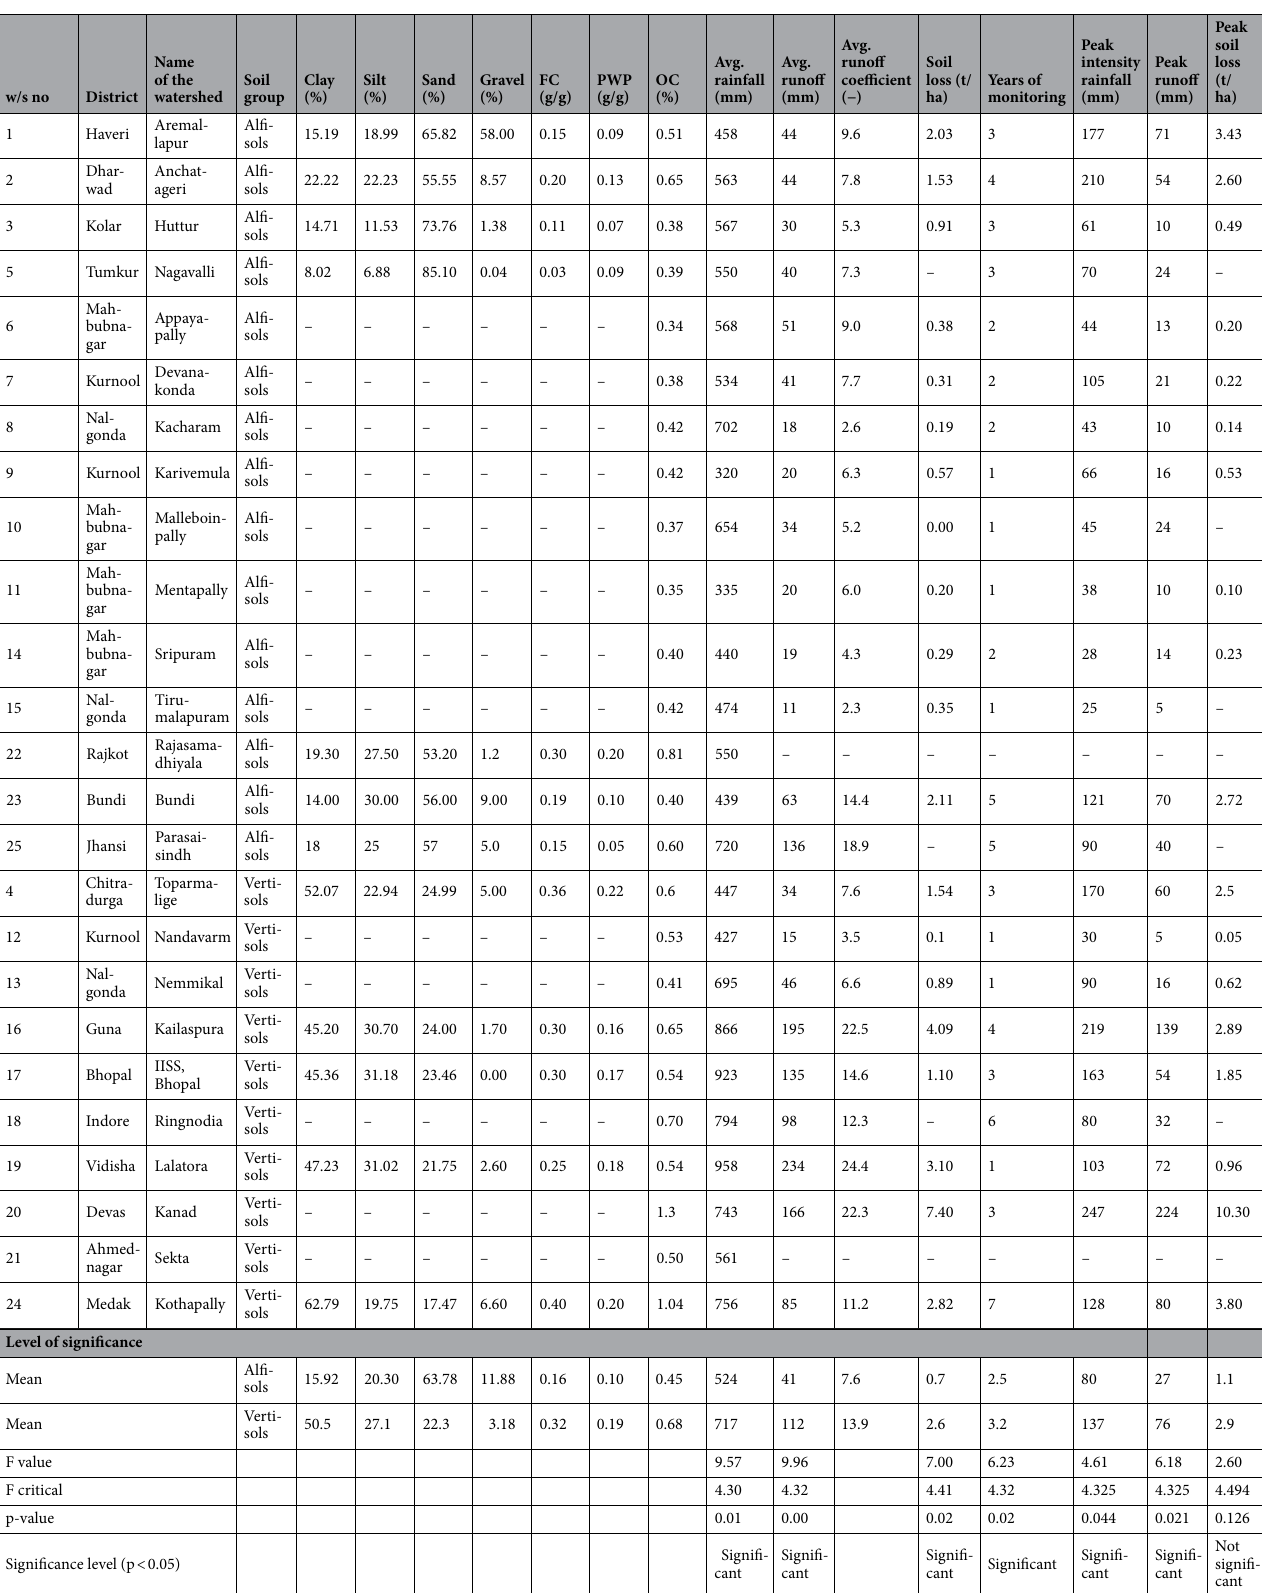
Table 2. Average annual rainfall, runoff and soil loss measured along with peak intensity events in different pilot watersheds in the semi-arid tropics. FC Field capacity, PWP Permanent wilting point, OC Organic